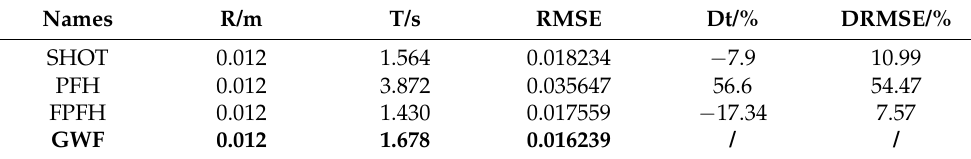
Table 3. Comparison of experimental results of different descriptors (R = 0.012 m).